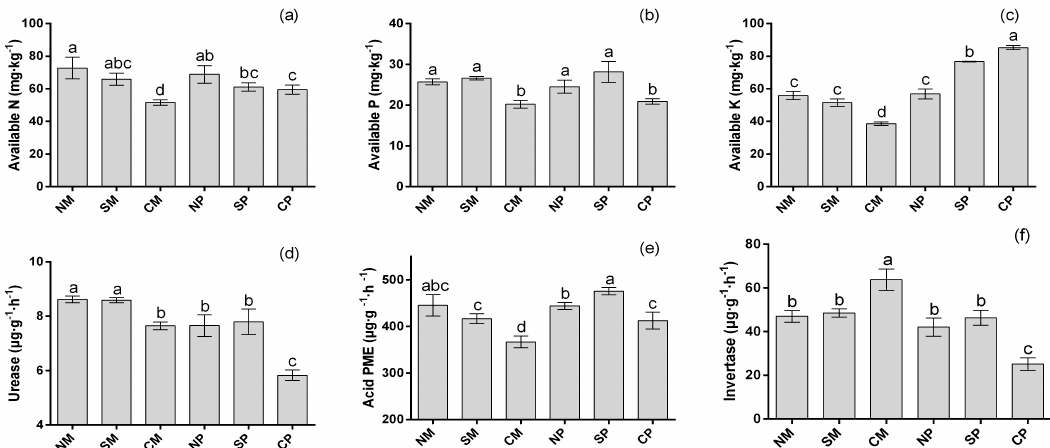
Figure 1. Soil available N ( a ); available P ( b ); available K ( c ); urease activity ( d ); acid PME (phosphomonoesterase) activity ( e ); and invertase activity ( f ) under different intercropping treatments. NM: non-separated maize; SM: semi-separated maize; CM: completely separated maize; NP: non-separated peanut; SP: semi-separated peanut; CP: completely separated peanut. Bars with different letters indicate significant differences (LSD test, p < 0.05, n = 3).